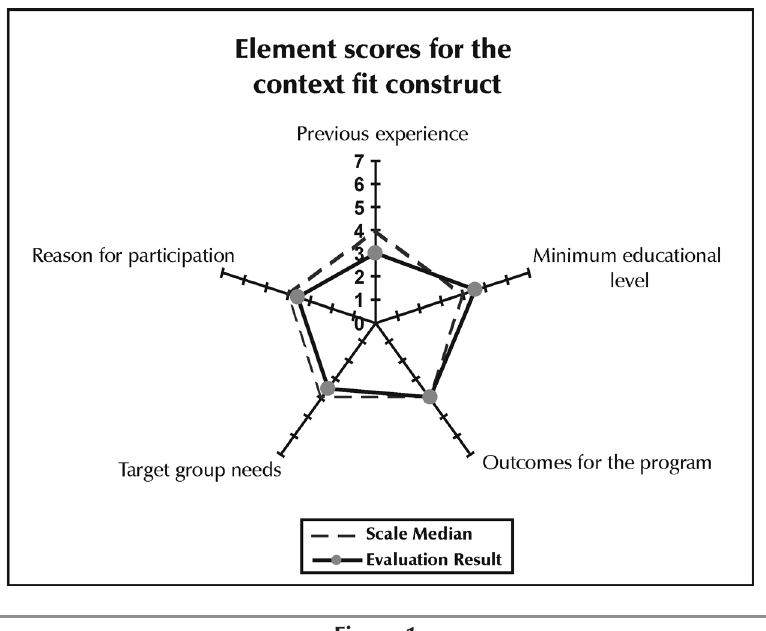
Graphical representation of evaluation results for the elements of the context fit of the NVCL compared to the